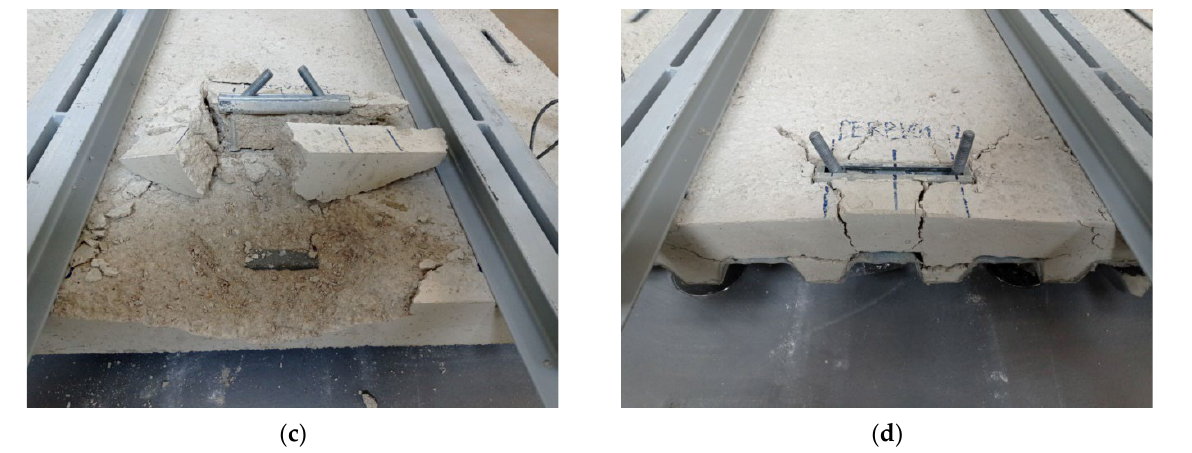
Figure 14. Breakout patterns for: ( a ) configuration 1; ( b ) configuration 2; ( c ) configuration 3; and ( d ) configuration 4.